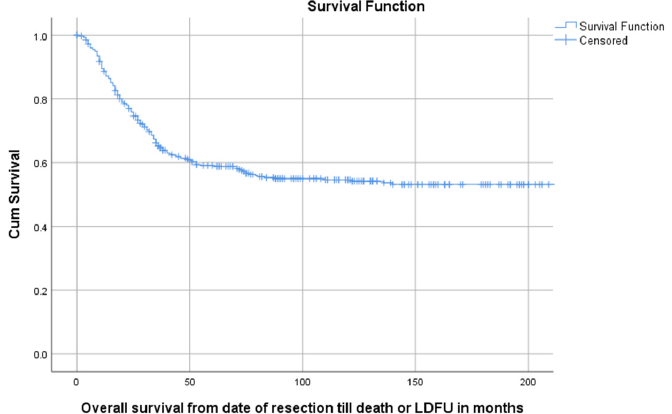
Figure 3. KM estimation of OS in the total cohort (upper panel) and of patients with and without distant metastasis (lower panel). Legend: OS = overall survival, DM = distant metastasis at presen- tation, cum survival = cumulative survival, LDFU = last date of follow-up. 3.4. Event Free Survival Of all 402 patients, 55.5% (223/402) experienced an event defined as LR, progression of metastasis, diagnosis of new metastasis or death. The 5-year EFS for 114 children, 218 AYA and 70 older adults was, respectively, 58.5% (95%CI 49.29–67.71), 40.6% (95%CI 33.94–47.26), 38.9% (95%CI 27.34–50.46) as can be seen in Table 3 and Figure 4. A total of 1, 3 and 5 years after surgery the event-free survival was, respectively, 71.6% (95%CI 67.1– 76.1), 49.2% (95%CI 44.3–54.1) and 45.3% (95%CI 40.4–50.2) (Figure 5).